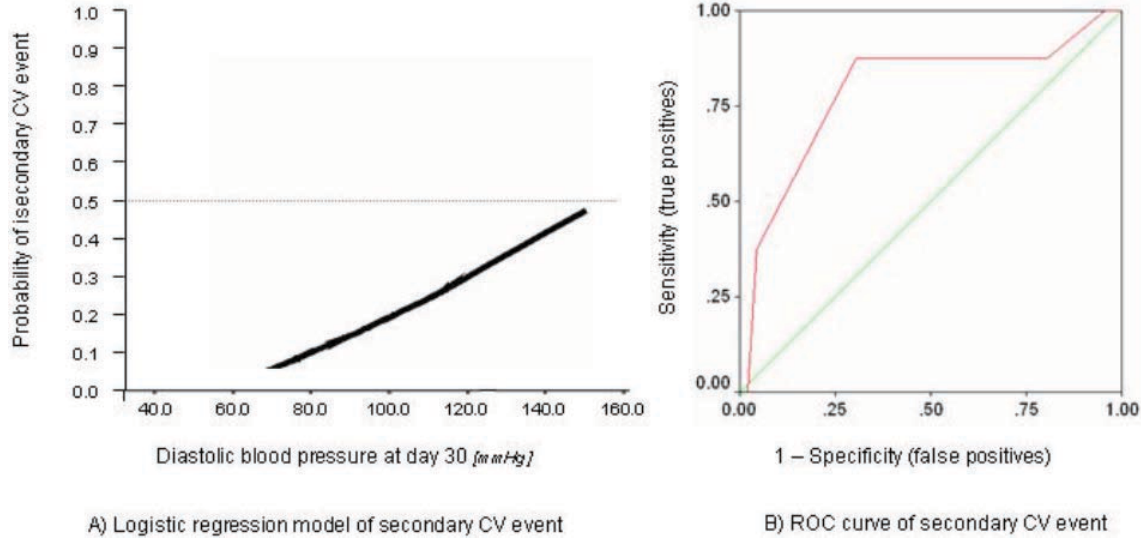
Figure 3. Models of secondary CV event (IS) and diastolic blood pressure at day 30 in MIS patients. A) Probability of CV event expressed as a nonlinear relationship along the diastolic blood pressure range at day 30 post-MIS (pmodel<0.05). X-axis, Blood pressure [mmHg]; Y-axis, probability of CVE (where 0.0=no CV event; 1.0=CV event); horizontal line, cut-off event probability of 0.5; B) ROC curve of CV event versus diastolic blood pressure: for a given DBP level, the ordinate values indicate the corresponding true- positive rate (fraction of CVE patients with this DBP) and the abscissa values indicate the corresponding part of the false-positive rate (fraction of patients without CVE with this DBP). The inflection point of the curve was chosen as the optimal diagnostic value. The larger area between the ROC curve and the diagonal line reflects the higher degree with which the DBP parameter shows a predictive benefit. X-axis, 1-Specificity; Y-axis, Sensitivity. Both estimates are expressed as a proportion of patients without or with CV events (i.e., from 0.00 to 1.00).